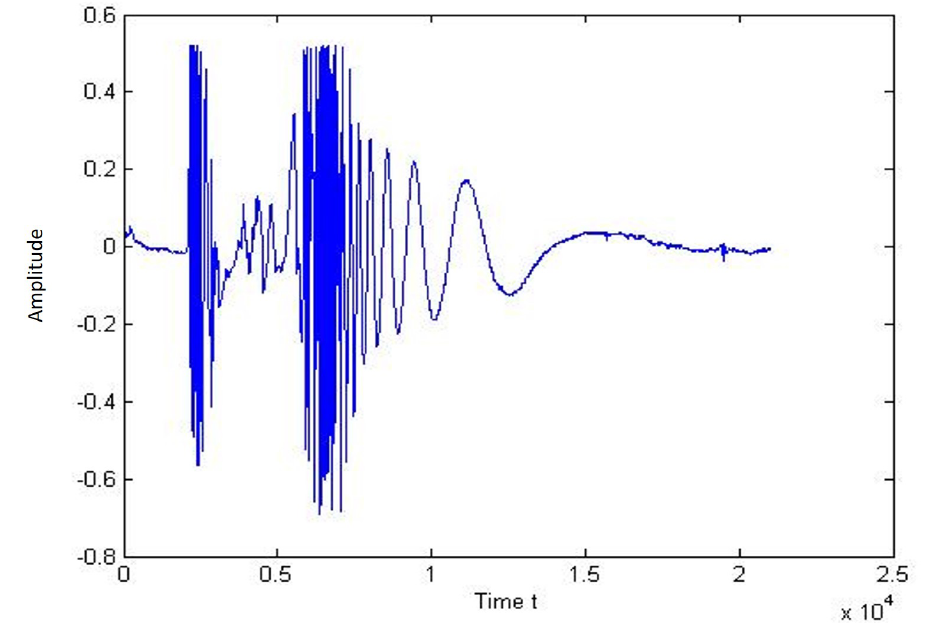
Figure 16. Plot of signal for the walk of a single